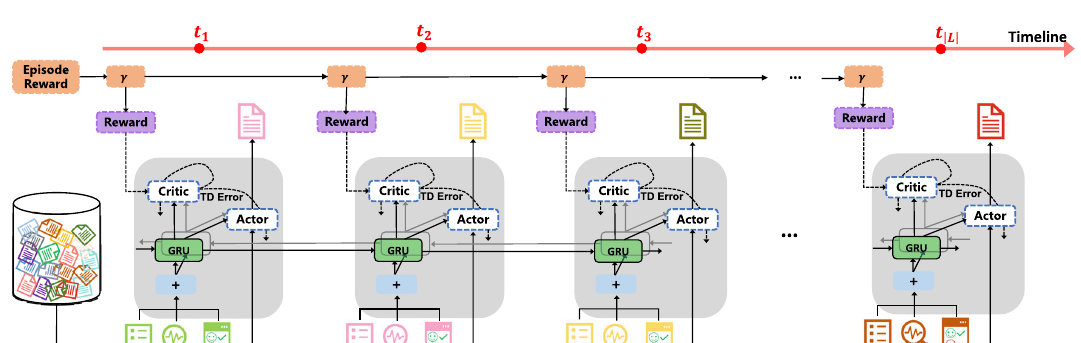
r t according to the student’s feedback, where we design a multi-objective reward function. The details of the reward function are discussed in the following